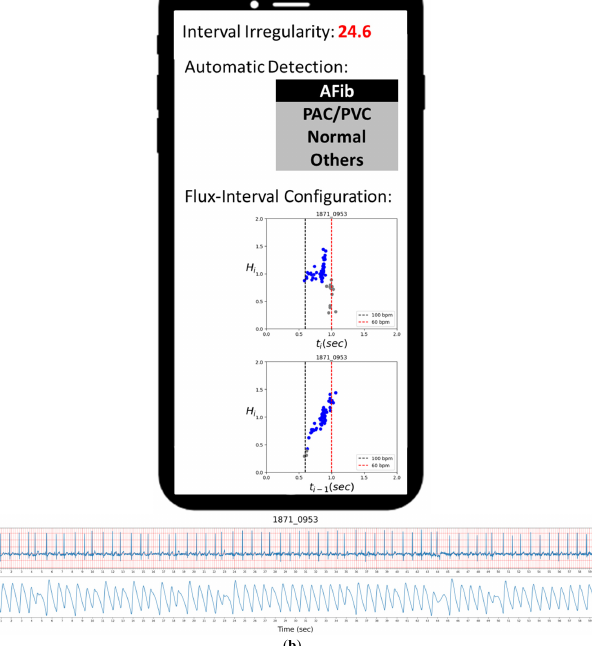
Figure 7. Two false-positive cases of premature contractions (non-AFib) classified as AFib. In both cases, frequent PACs were encountered, but these PACs came with different coupling intervals if measured carefully ( a , b ). In addition to the PAC attacked in case ( a ), a short-run atrial tachycardia (AT) attacked around time mark 39 s. 4.1. Visual Reassessment Figure 7a,b presents the two false-positive cases of ECG-labeled PAC samples mis- classified as AFib by our automated detection, while their flux-interval plot tells a dif- ferent story. Upon visually reassessing the flux-interval plots in both configurations fol- lowing the guideline in Table 2, we can clearly see that in both cases, the ( t i , H i ) plot did not present itself in a single widely scattered cluster and multiple clusters can be identi- fied. In the case of Figure 7a, it appears as sinus rhythms with PAC, but with a short ep- isode of atrial tachycardia (multiple APC in short succession) in the mix at around 39 s mark, thus resulting in the resemblance of AFib. In the case of Figure 7b, the false-positive lies in the presence of various kinds of PAC with different coupling inter- vals ( t i − 1 ). These false-positive results could be attributed to the limitation of the clustering algorithm to differentiate these turbulences of RR-interval when complex arrhythmias